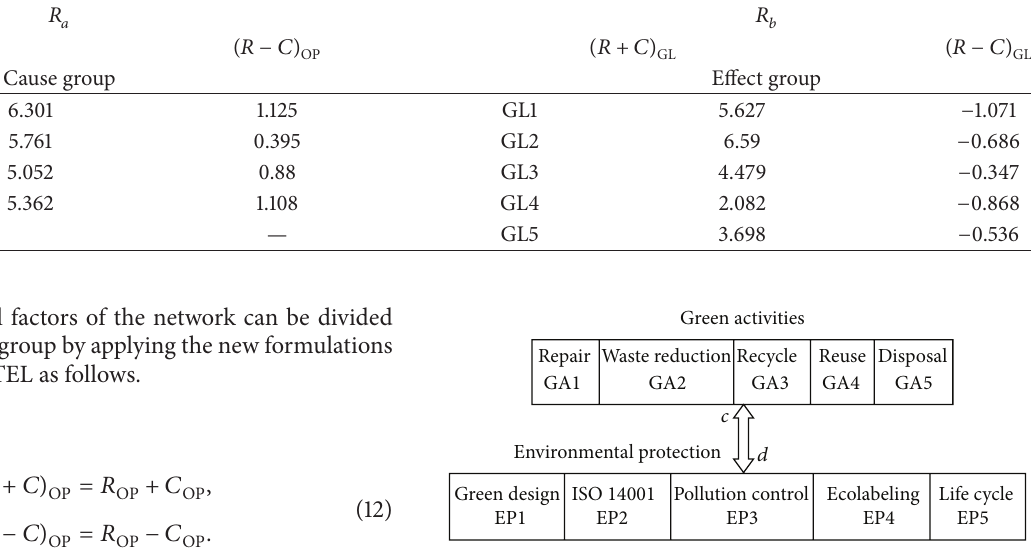
Figure 4: Conceptual network 2: green activities and environmental